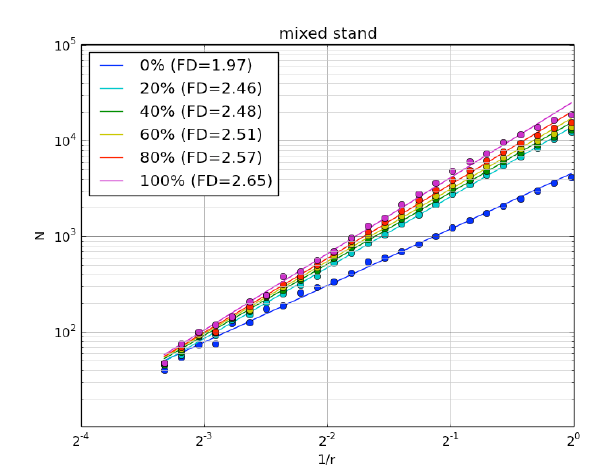
Figure 9: Box-counting analysis of point cloud data simulated for the mixed